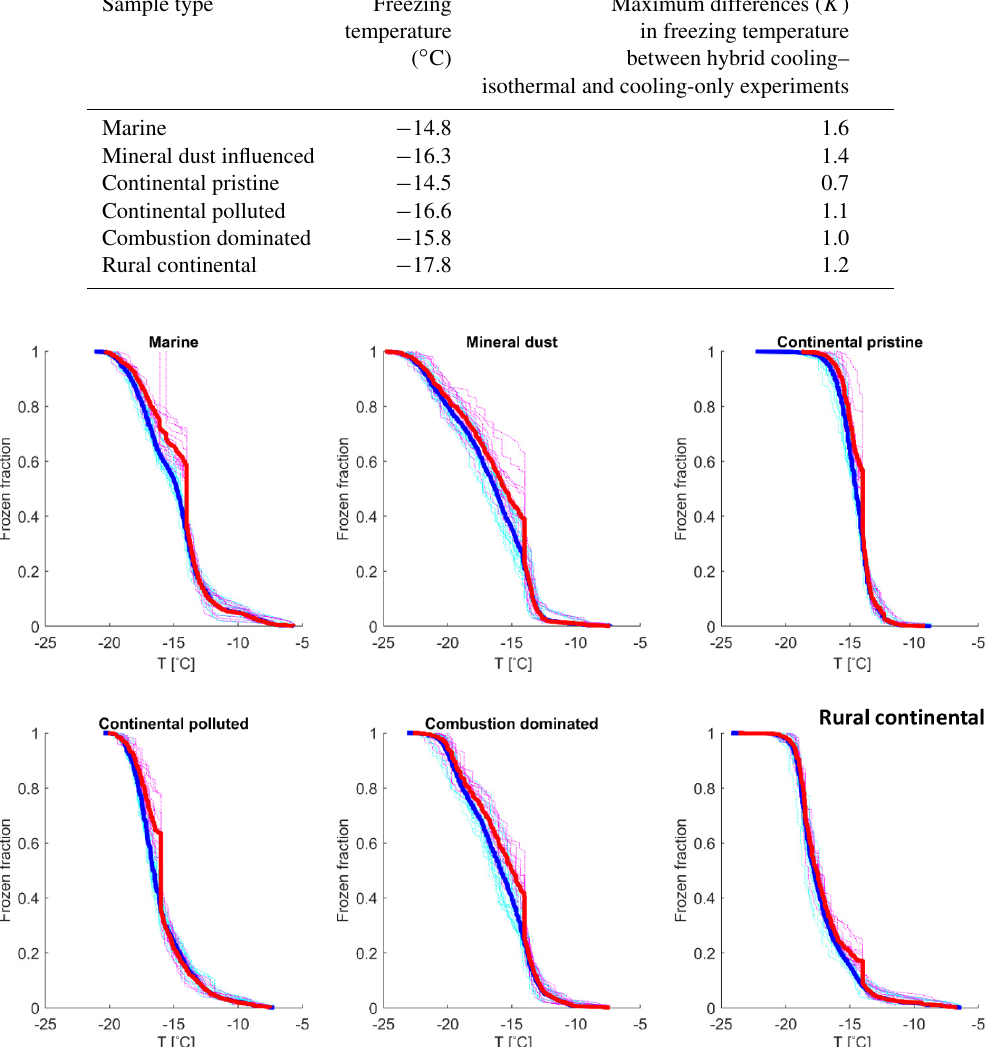
Figure 14. Frozen fraction raw data for the constant cooling rate experiments (dotted cyan lines) and for isothermal experiments of 2h (dotted magenta lines) for the marine, mineral-dust-influenced, continental pristine, continental polluted, combustion-dominated and rural continental samples of aerosol material (panels from top left to lower right). The large steps for two isothermal experiments displayed for the marine sample is an effect of a camera lag, not a physical effect, as they occur after the isothermal phase this does not influence the result. The averaged data for constant cooling rate experiments (blue lines) and isothermal experiments (red lines) are also shown. The offset seen for the isothermal experiments at the isothermal temperature is the effect of the 2h isothermal phase of the experiment. As seen in the figure, the samples behave almost identically until the isothermal phase is reached, and the isothermal data approach the constant cooling rate data after the isothermal phase has elapsed, and constant cooling is